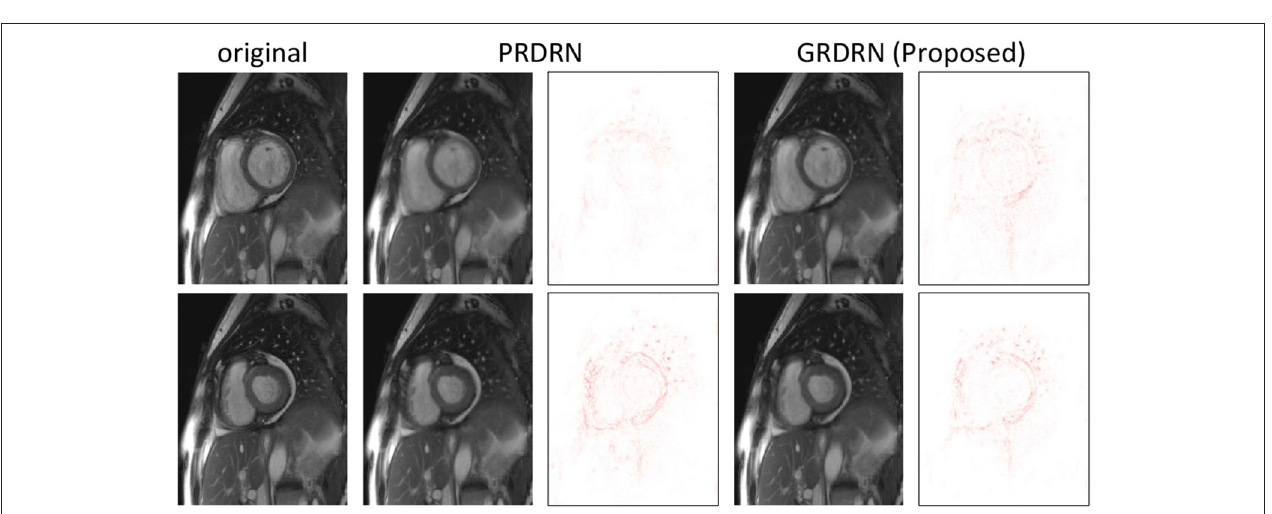
FIGURE 6 | Visualization of generated dynamic images with motion fields estimated with PRDRN (pairwise registration) and proposed GRDRN (groupwise registration) models trained in 12 × accelerated data. Two representative frames at diastole and systole are shown with the corresponding error maps.